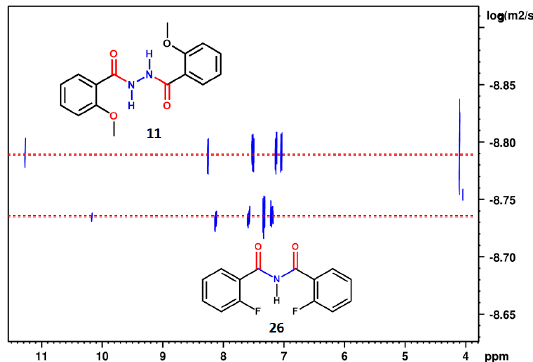
Figure 27. 500 MHz 1 H-DOSY NMR spectrum of 20 mM solution of the mixture of molecules 11 and 26 at a 1:1 molar ratio in CDCl 3 .